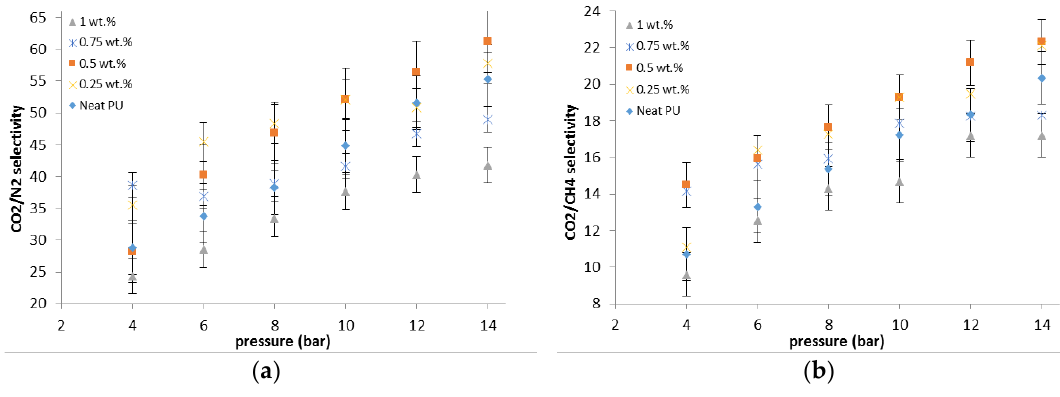
Figure 8. ( a ) CO 2 /N 2 and ( b ) CO 2 /CH 4 selectivities of PU-ZnO MMMs.